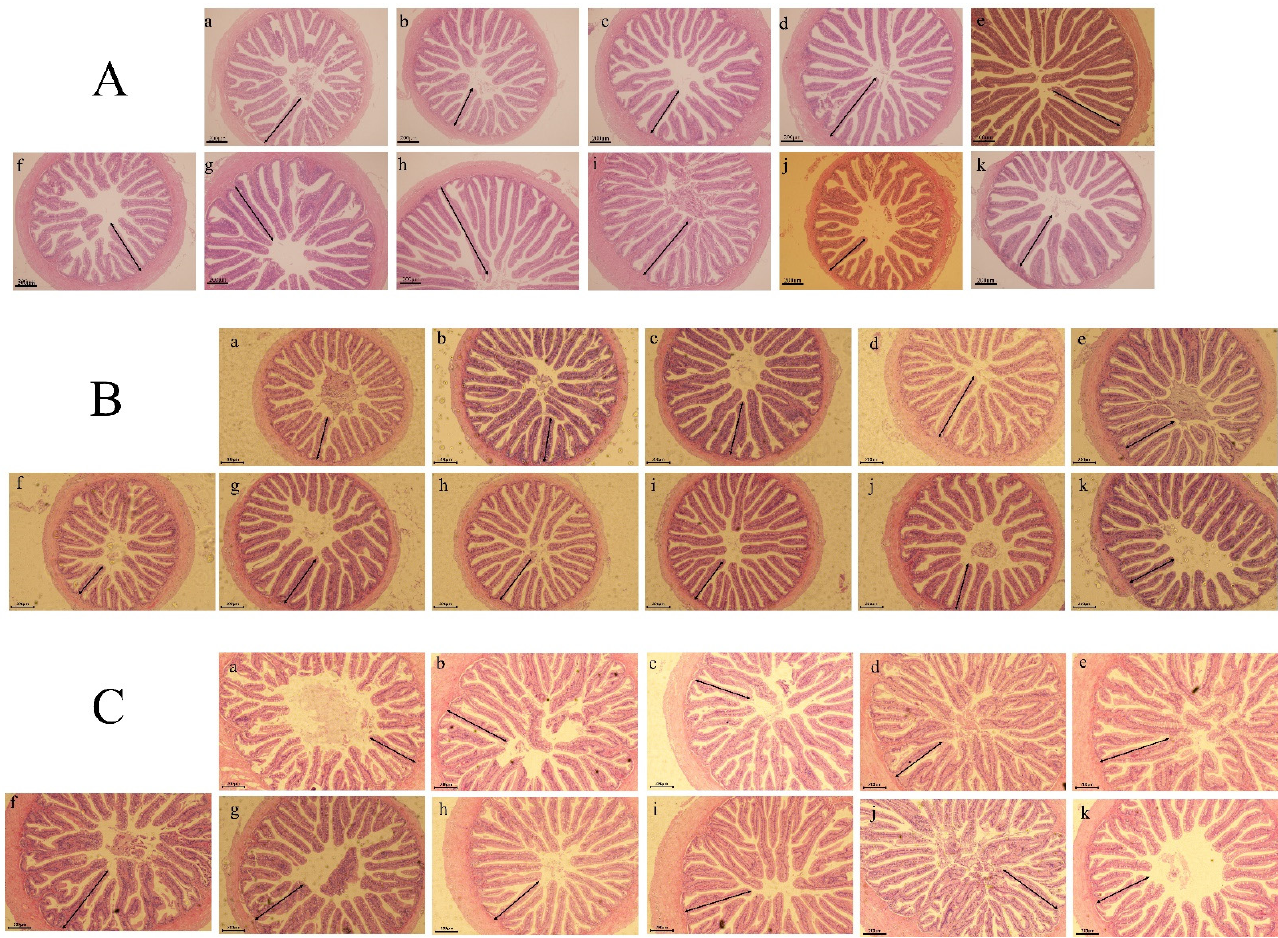
Figure 2. Light microscopy of gut morphology of hybrid grouper juveniles in fish fed different PMBP replacements by CCMP and LGCMP for 9 weeks (hematoxylin–eosin staining; original mag- nification 10×), ( A ): foregut, ( B ): midgut, ( C ): hindgut; (a): PBMP, (b): CCMP20, (c): CCMP40, (d): CCMP60, (e): CCMP80, (f): CCMP100, (g): LGCMP20, (h): LGCMP40, (i): LGCMP60, (j): LGCM80, (k): LGCMP100.